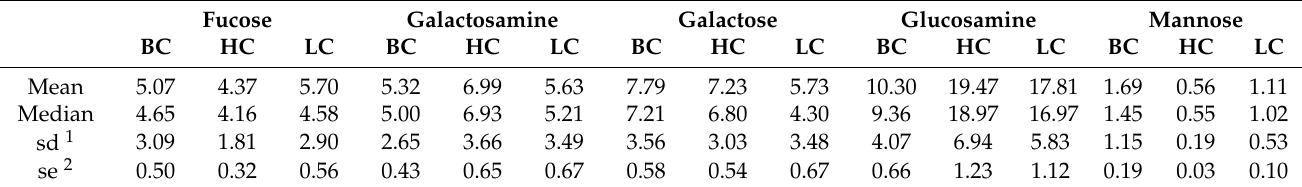
Table 3. Concentrations in mg/dL of the hydrolyzed carbohydrates as determined by HPAEC-PAD. Fucose